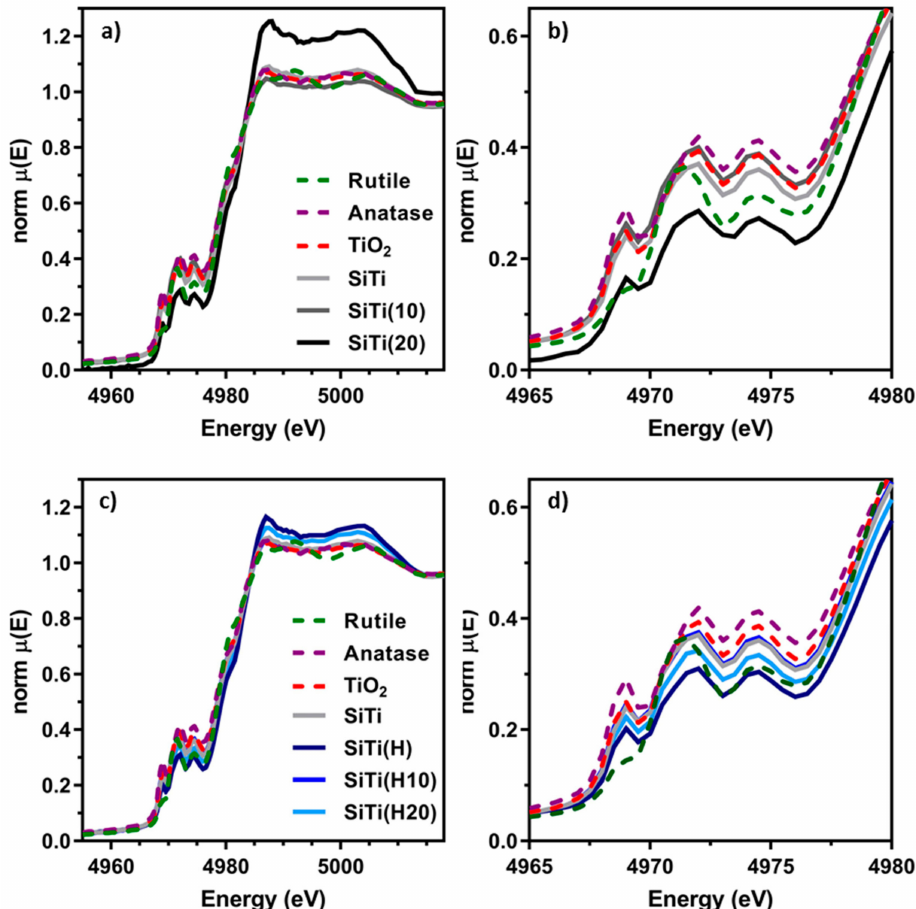
Figure 6. ( a ) Ti − K edge and ( b ) pre-edge XANES for FSP-synthesized SiTi before and after 10 and 20 min of plasma treatment. ( c ) Ti − K edge and ( d ) pre-edge XANES for FSP-synthesized SiTi after hydrogenation and / or 10–20 min of plasma treatment. Pure anatase, rutile, and FSP-prepared TiO 2 controls are also